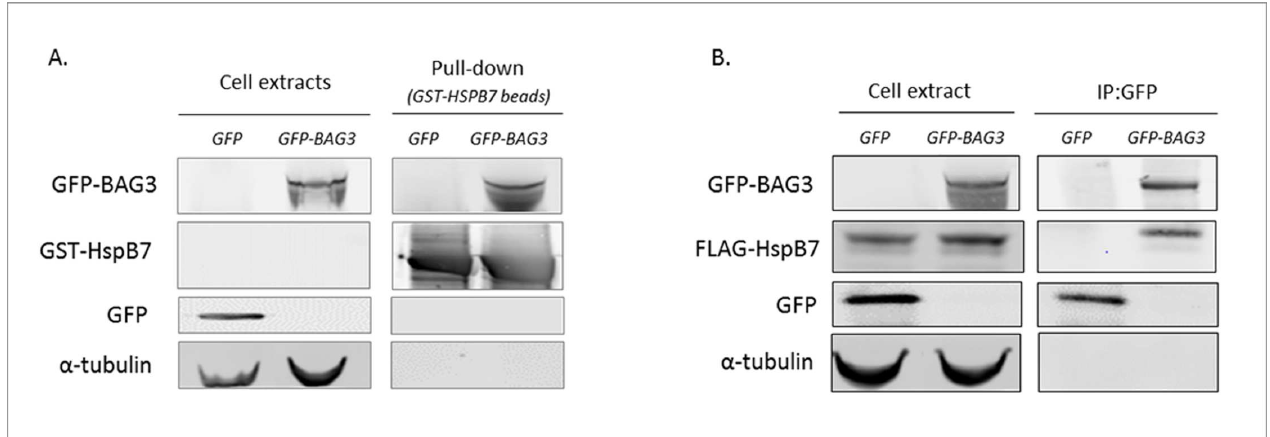
Fig 4. BAG3 interacts with HspB7. (A) GST Pull-Down showinginteraction of GFP-BAG3 expressedin HEK293 cells and recombinant GST-HSPB7. GFP-BAG3 was expressed in HEK293 cells (cell extract panel)and and GST-HSPB7 was producedin a bacterial expressionsystem. GST-HSPB7 co-sediment with GFP-BAG3 but not with GFP alone indicating specific BAG3/GST-HSPB7 interaction (Pull-Downpanel).(B) Co- immunoprecipitationexperiment showinginteraction of Flag-HSPB7and GFP-BAG3 in HEK293 cells. GFP alone or GFP-BAG3 were co-expressed together with Flag-HSPB7in HEK293cells (cell extract panel)and subjectedto immunoprecipitation with an antibody againstGFP. Only GFP-BAG3 immunoprecipitatedwith FLAG-HSPB7 (IP:GFP panel). Western blottings in (A) and (B) used HSPB7 (for GST-HSPB7), GFP (for GFP and GFP-BAG3), and α -tubulin specific